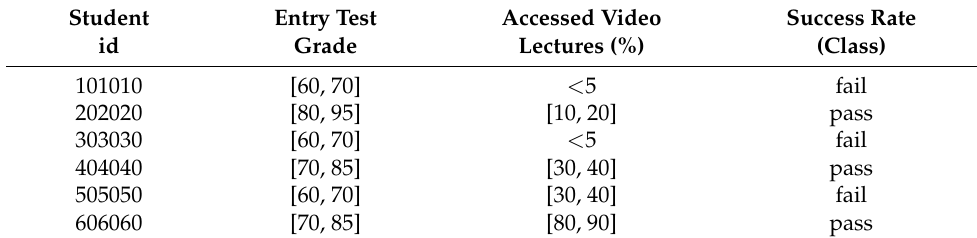
Table 1. Running